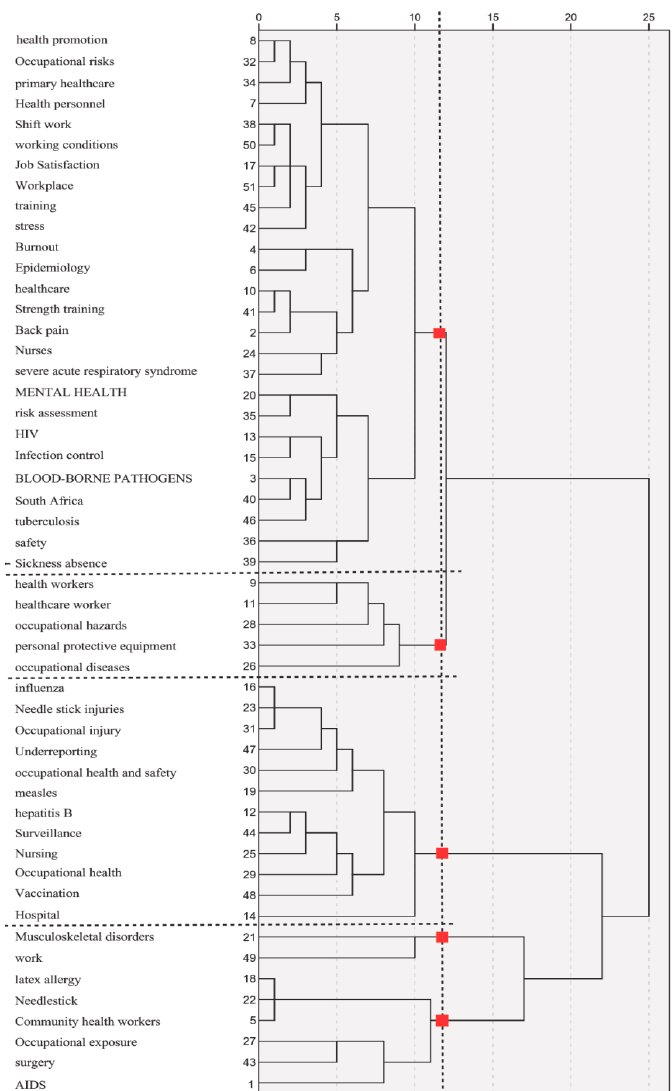
Figure 6. Keyword co-occurrence hierarchical cluster graph for the field of HCWs+OH research.